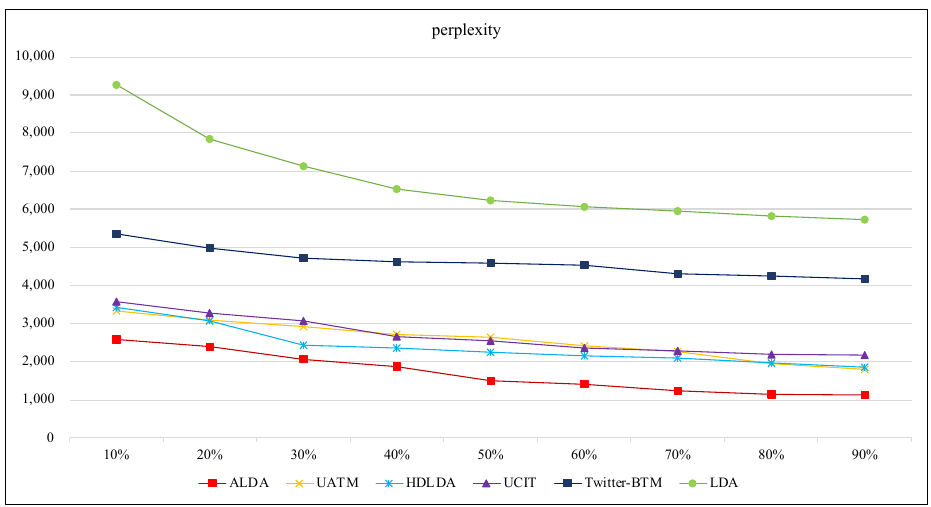
Figure 4. Comparison of user’s preference inferring performance.